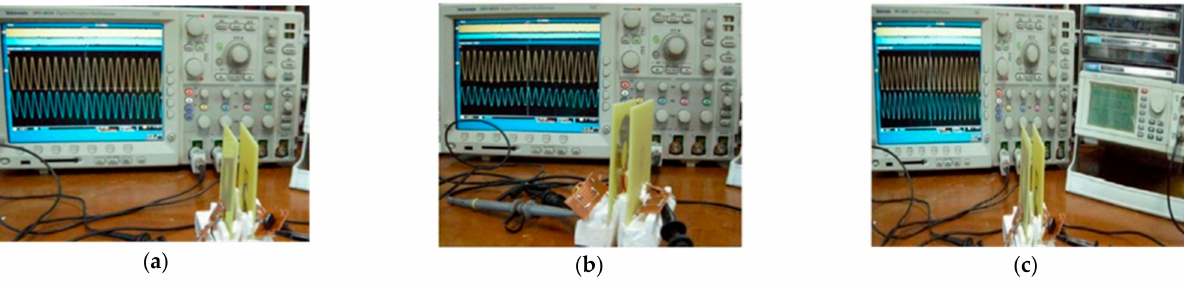
Figure 1. The fabricated coils on the PCB, for 3D printed support structures: ( a ) square coil topology; ( b ) circular coil topology; ( c ) hexagon